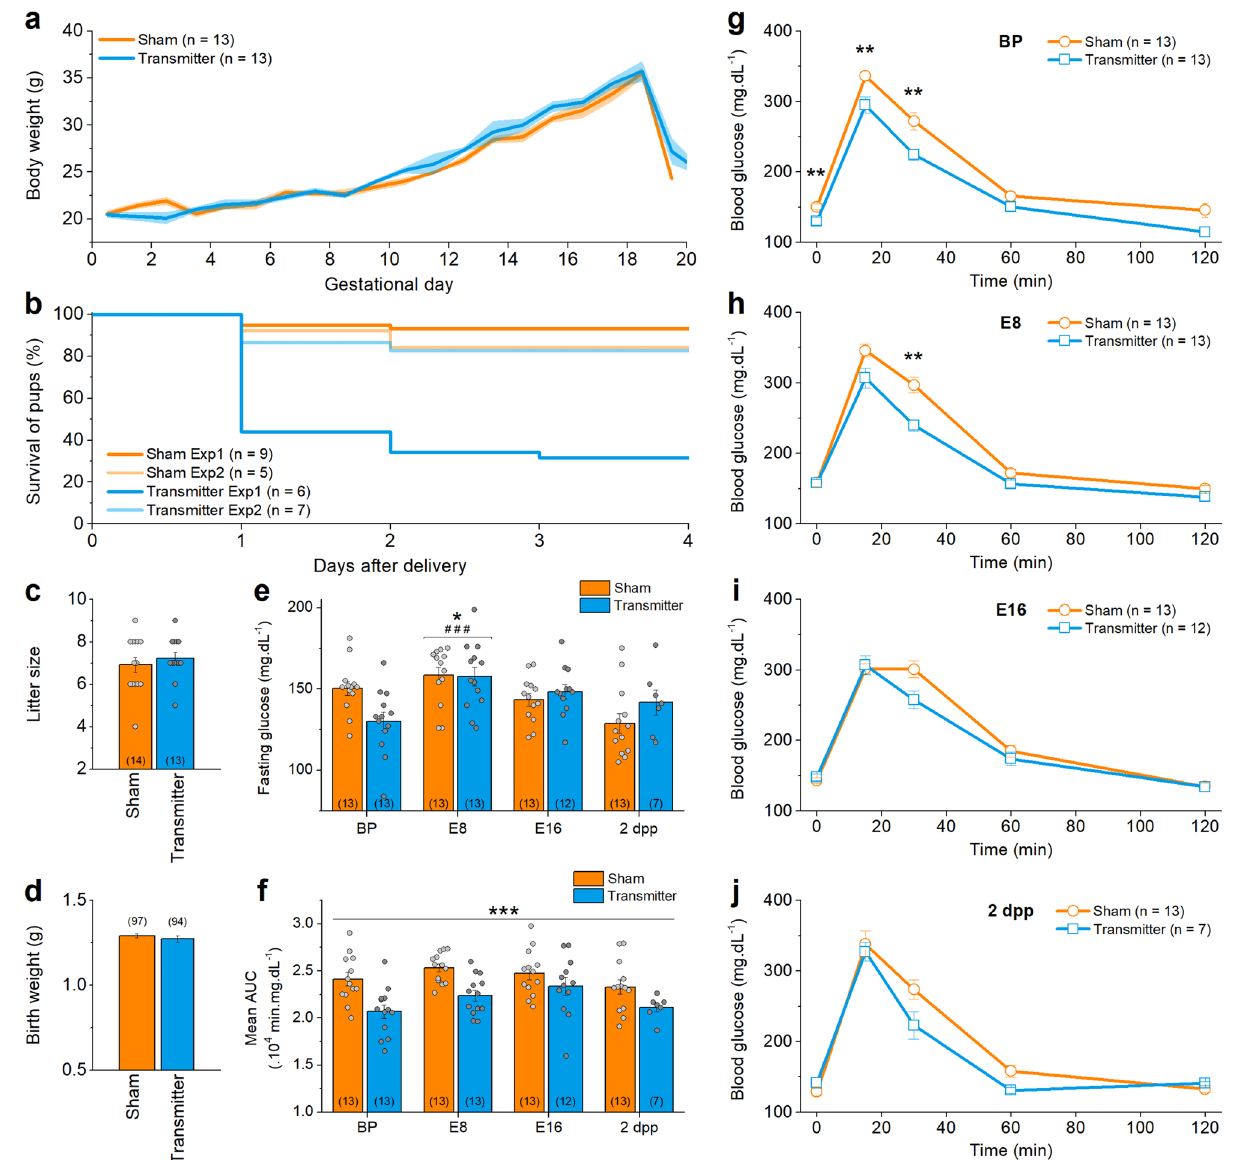
Figure 2. Pregnancy and manually measured OGTTs in sham group versus transmitter group. ( a ) Mean body weight ± s.e.m. during pregnancy is similar in transmitter and sham group (t-test with Holm-Sidak multiple comparison correction). ( b ) Survival of the pups during the days after delivery is different in experiment 1 (Exp1, p < 0.0001) and not in experiment 2 (Exp2, p = 0.66) (Mantel-Cox test). ( c ) Number of pups per mother, arithmetic mean ± s.e.m., is not significantly different. ( d ) Mean birth weight ± s.e.m. is not significantly different. ( e ) Fasting glucose values, arithmetic mean ± s.e.m., change significantly over the course of pregnancy (Two- way ANOVA). *: difference compared to BP, #: difference compared to 2dpp. ( f ) AUC, arithmetic mean ± s.e.m., of the OGTT from transmitter-implanted or sham treated mice. The mean AUC in the transmitter group is significantly lower compared to the sham group (Two-way ANOVA). ( g ) OGTT before pregnancy (BP), ( h ) at embryonic developmental day 8 (E8), ( i ) at embryonic developmental day 16 (E16) and ( j ) 2 days postpartum (2 dpp) (two-sample t-tests with Bonferroni correction). The number of animals is indicated on the figures between brackets for every condition. See also supplementary Fig. glucose levels are more variable than the higher blood glucose levels throughout pregnancy (Fig. 6c, difference between min and max value: 30 mg.dL −1 (P5) vs. 19 mg.dL −1 (P95) and supplementary Fig. S3c). This indicates that rather a change in basal glucose results in elevated glucose levels during pregnancy. The mean amplitude of glucose excursions (MAGE), reflecting short-term glucose variability, appears to be higher before and after pregnancy, compared to during pregnancy (Fig. 6d). Likewise, the mean iAUC of glucose excursions follows a similar pattern throughout pregnancy, but the difference is less distinct (Fig. 6e). Time to peak and FWHM of glucose excursions do not significantly change throughout full pregnancy (Fig. 6f,i). The rising phase of a glu-